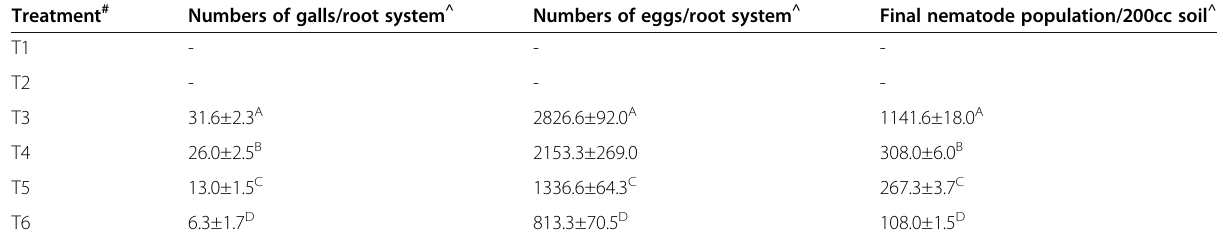
Table 2 Effect of Bacillus aryabhattai KMT-4 on nematode population after 45 days of treatment in pot experiment on brinjal ( Solanum melongena L.)